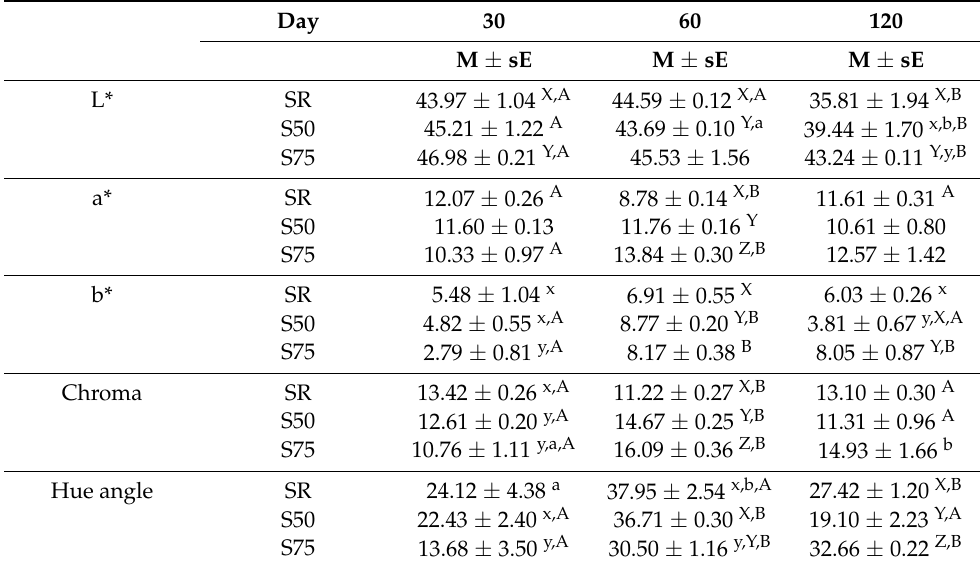
Table 6. Color measurements (CIE L*a*b*) of three salami (SR, S50, and S75) during